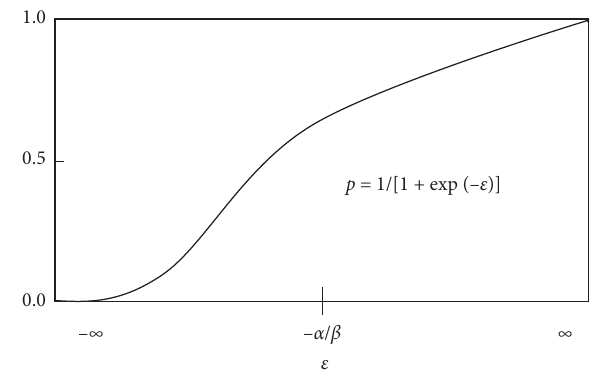
Figure 1: Graph of the logistic